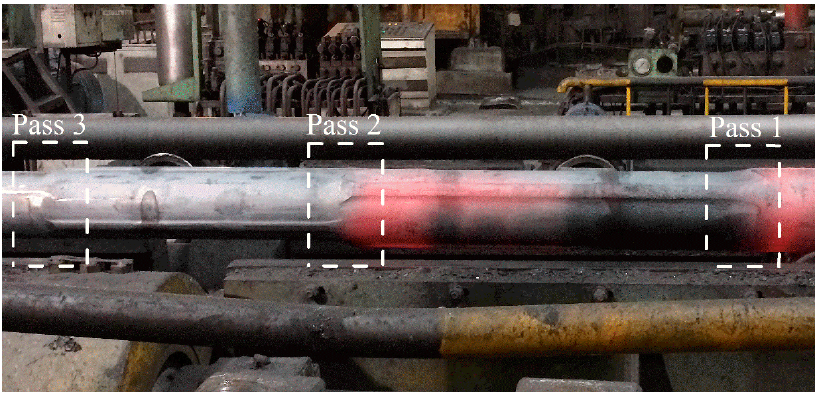
Figure 9. Shape of the tube-roll contact boundary on the specimen tube corresponding to the mill stand positions of pass 1–pass 3.